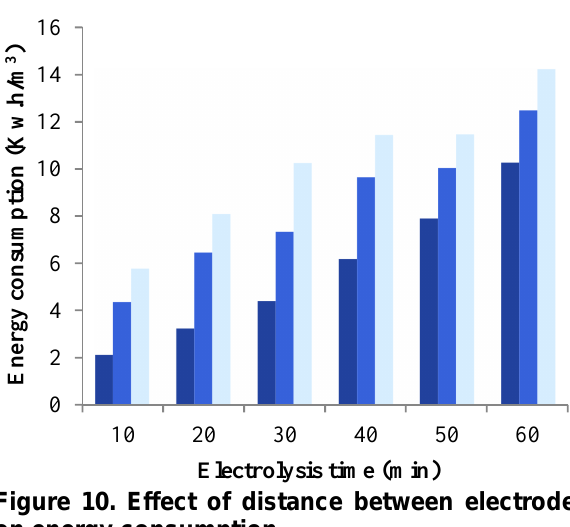
Figure 10. Effect of distance between electrodes on energy consumption (Voltage = 50 v, C 0 = 50 mg/l, KCl = 0.01 M, pH = 11, T = 22 ± 2 º